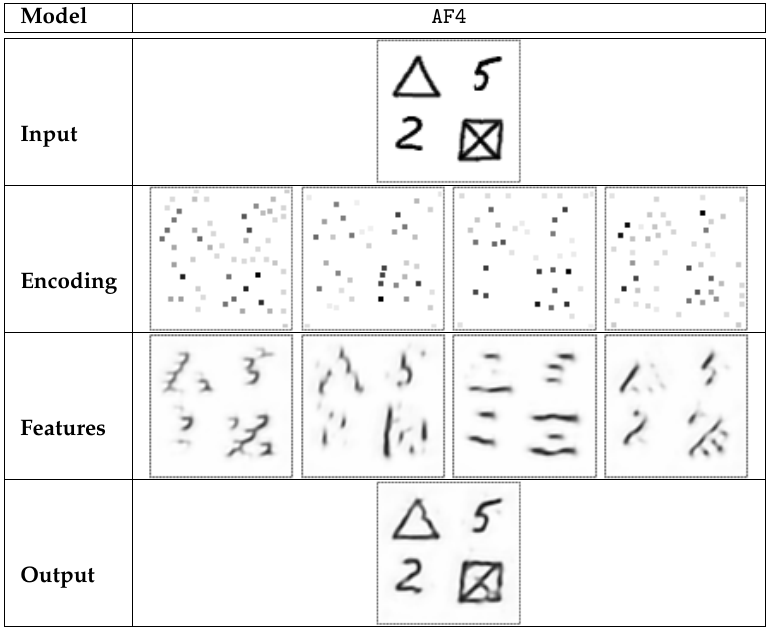
Figure 12. Sample encoding of a larger image that contains both digits and other symbols, performed with the AF4 model. The presented feature-specific decodings were generated in the same way as those presented in Figure